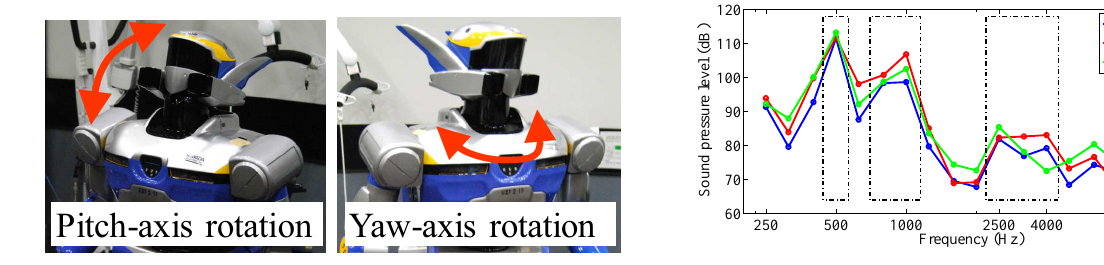
Figure 4. Power at each frequency band with 0-degree vocalization